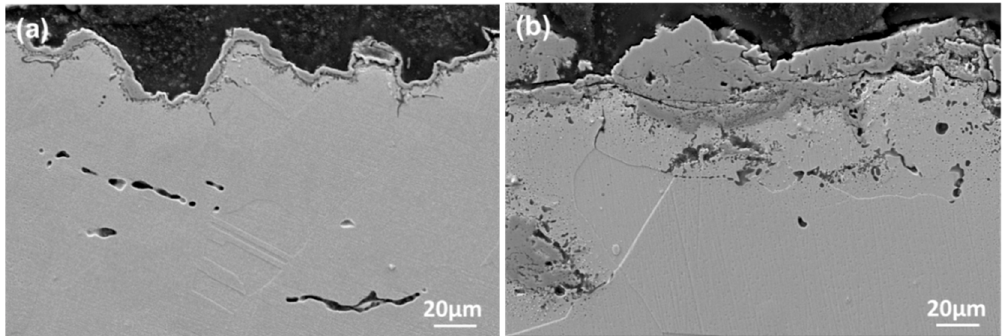
Figure 7. The cross-sectional morphologies of the specimens after the thermal fatigue tests under different T max conditions: ( a ) 800 °C and ( b ) 900 °C.